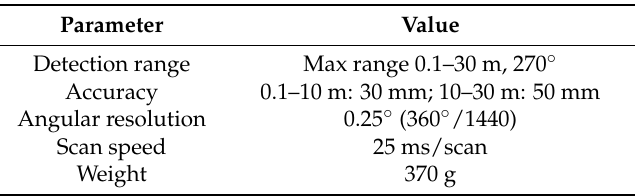
Table 1. Specifications of the laser scanner UTM-30LX [20].